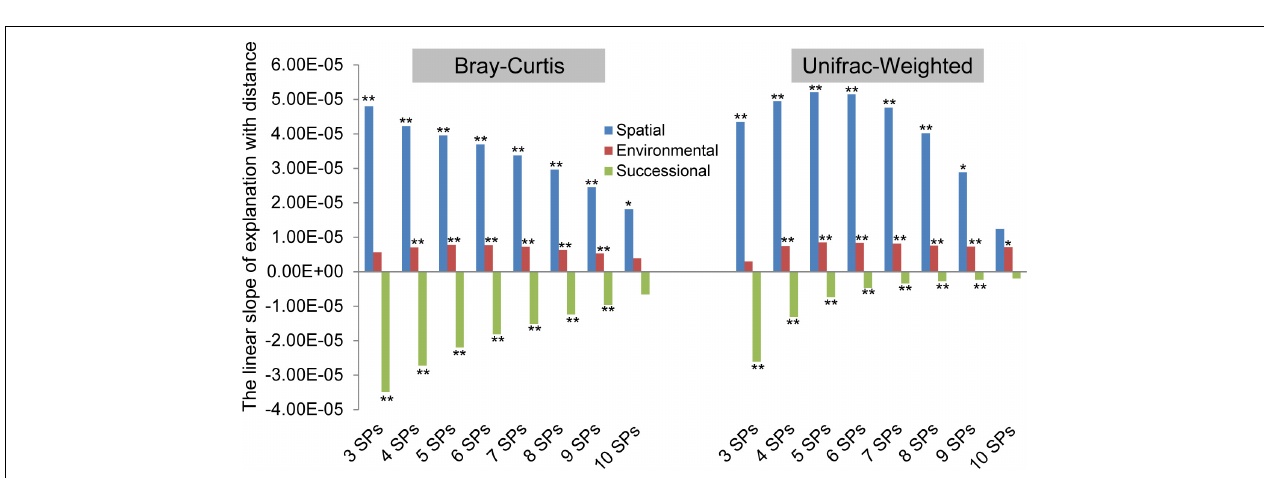
FIGURE 2 | The changes of archaeal biodiversity and assembly processes with succession. The Shannon index (A) was calculated in algae (A), Cyanobacterial lichen (C), and moss-dominated (M) crusts. The paired Bray–Curtis dissimilarities (B) were, respectively, calculated in A, C, and M successional crusts. Besides, the paired Bray–Curtis dissimilarities between different successional stages were also calculated (i.e., Between). The community differences among three successional stages were studied by analysis of similarities (ANOSIM). A significant difference among three successional stages using analysis of variance (ANOVA; df = 2, least significant difference, small letters indicated p < 0.05). The assembly processes (C) of archaeal community in different successional stages were quantified using Stegen’s method (Stegen et al., 2013). The topological characteristics (D) of co-occurrence network were calculated on the MENA website (http://ieg4.rccc.ou.edu/mena).